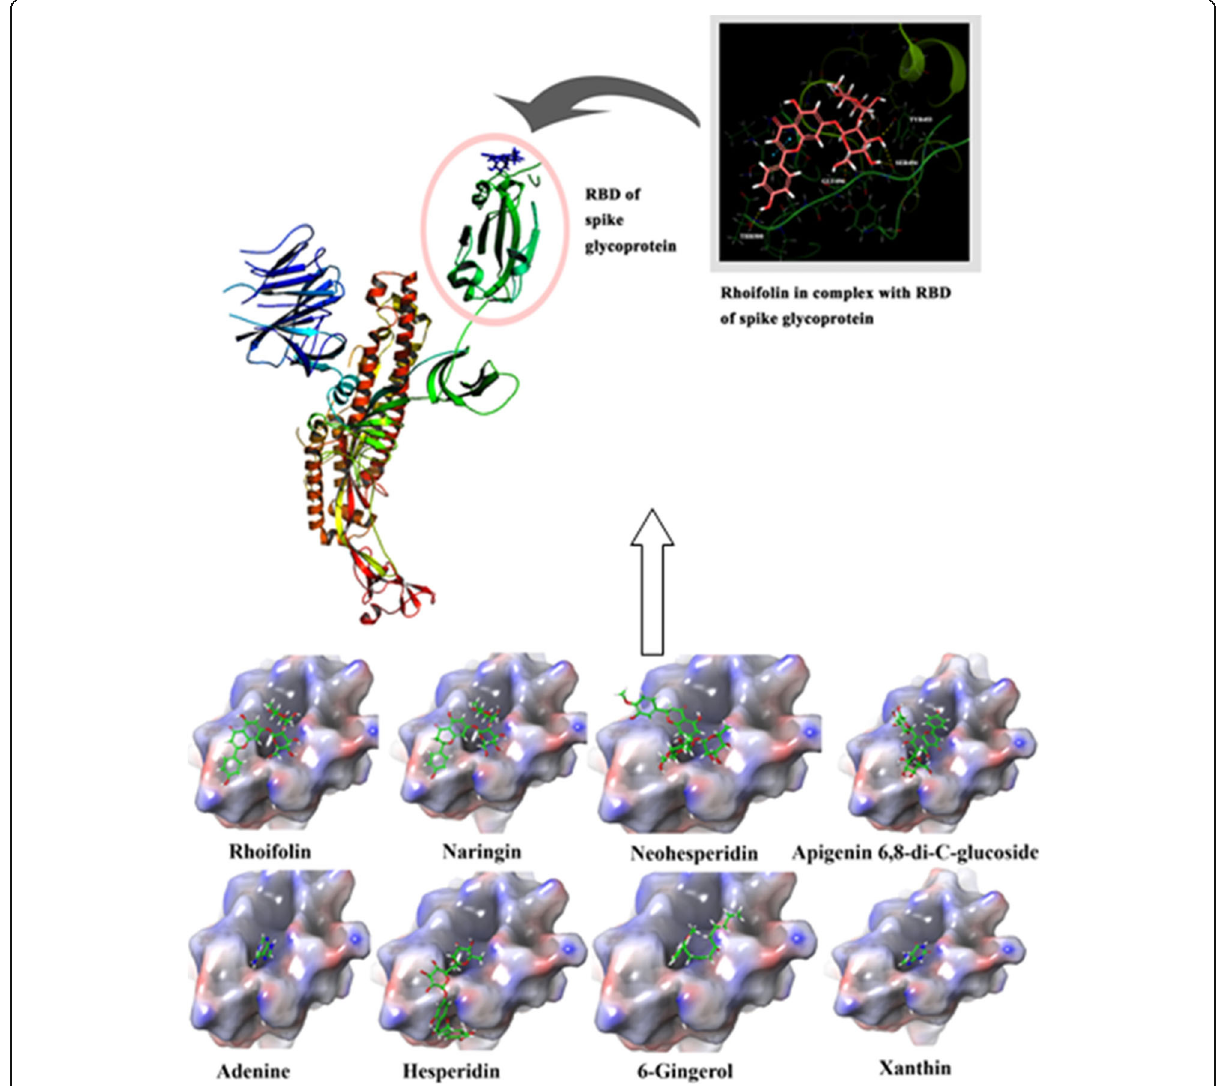
Fig. 2 Docked postures of the phytocompounds onto the receptor-binding site of the SARS-CoV-2 spike